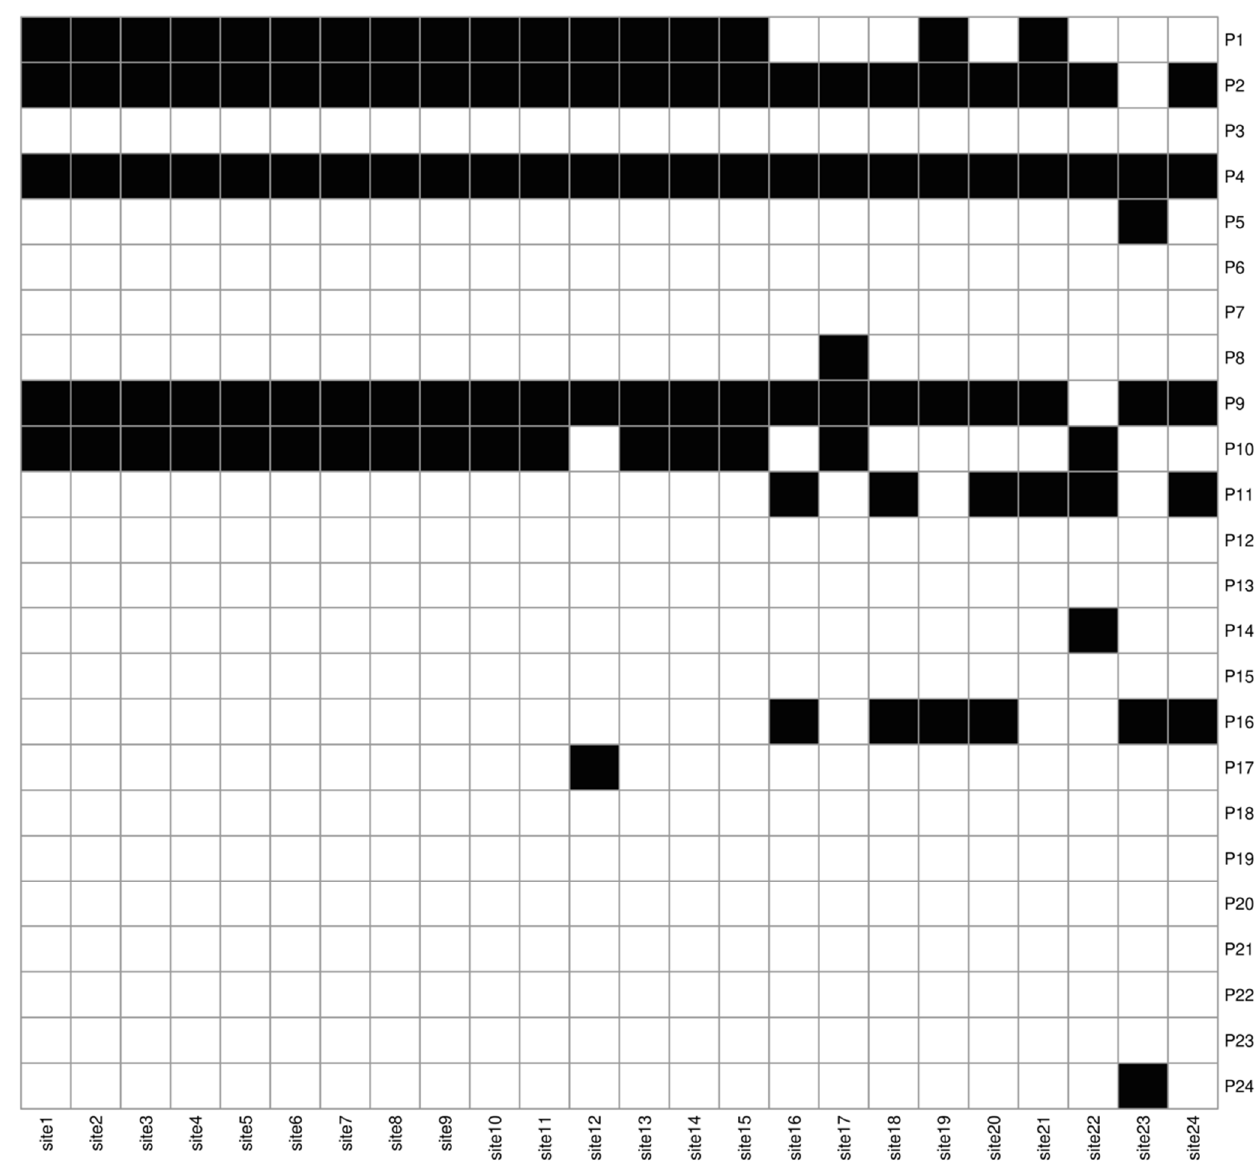
Figure 3. The sensitive parameter combination for the simulated soil carbon using the SA method based on CNOP-P (From research findings by Sun and Mu [47]. Parameter corresponding to the number can be found in studies by Sun and Mu [47] and Table S1 in Supplementary Materials).